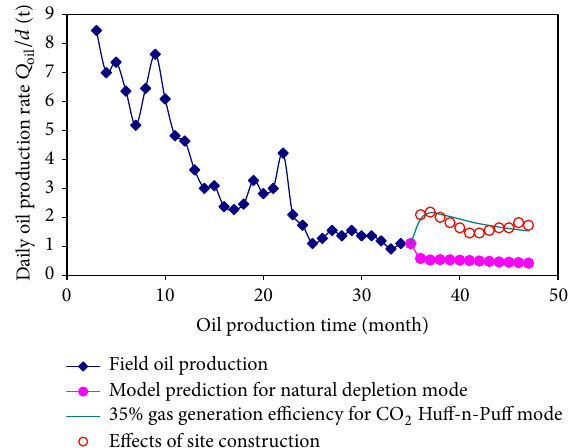
Figure 16: The daily oil production rate in different recovery modes.